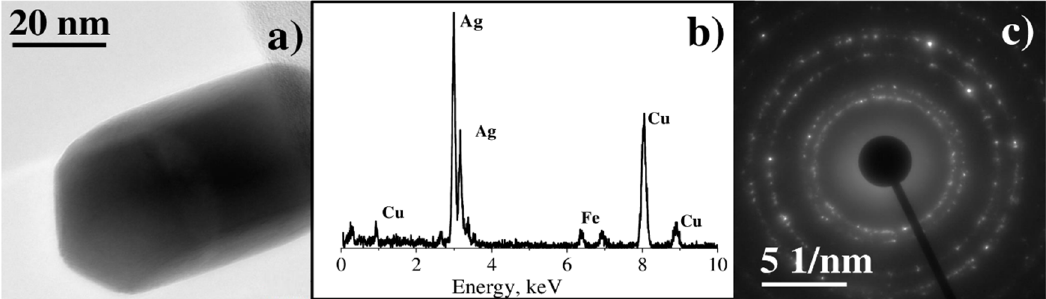
Figure 5. ( a ) Bright-field (BF) TEM image of large single crystal, ( b ) EDX spectrum, ( c ) electron diffraction pattern.